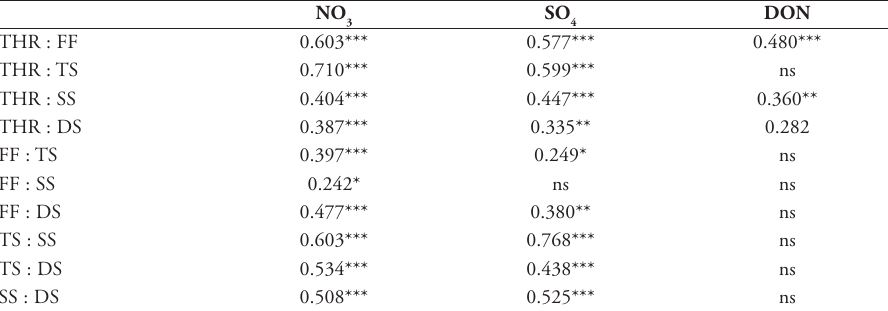
Table 3. Pearson correlation between monthly concentration of NO depositions (THR), forest floor leachate (FF), topsoil (TS = topsoil solution at 15 cm depth), subsoil (SS = subsoil solution at 40 cm depth) and deep soil (DS = deep soil solution at 70 cm depth).